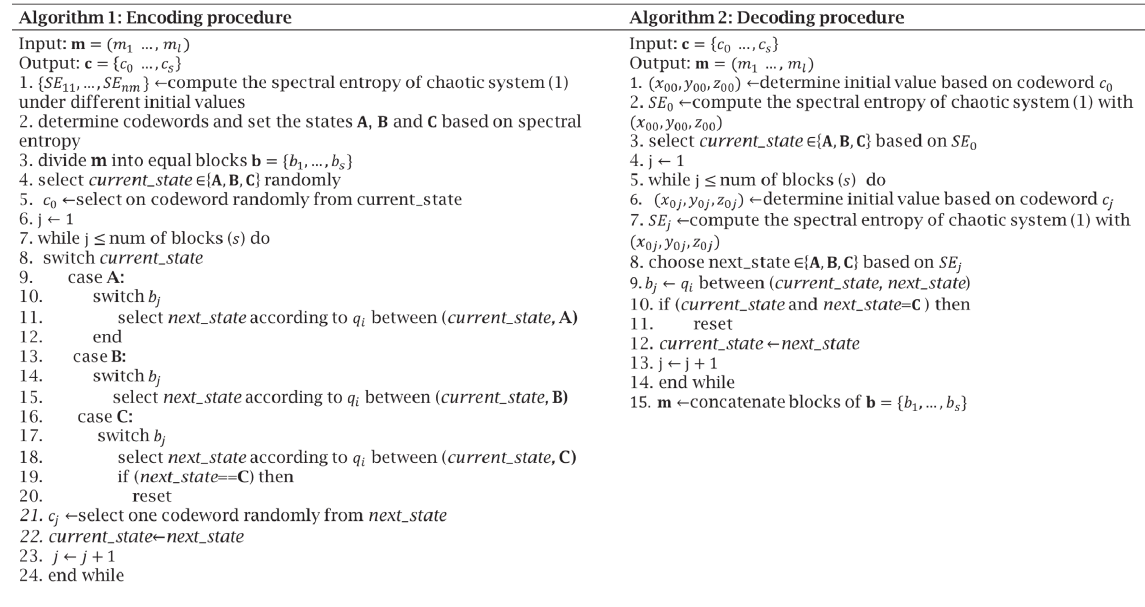
Figure 11: Pseudocode of the encoding and decoding